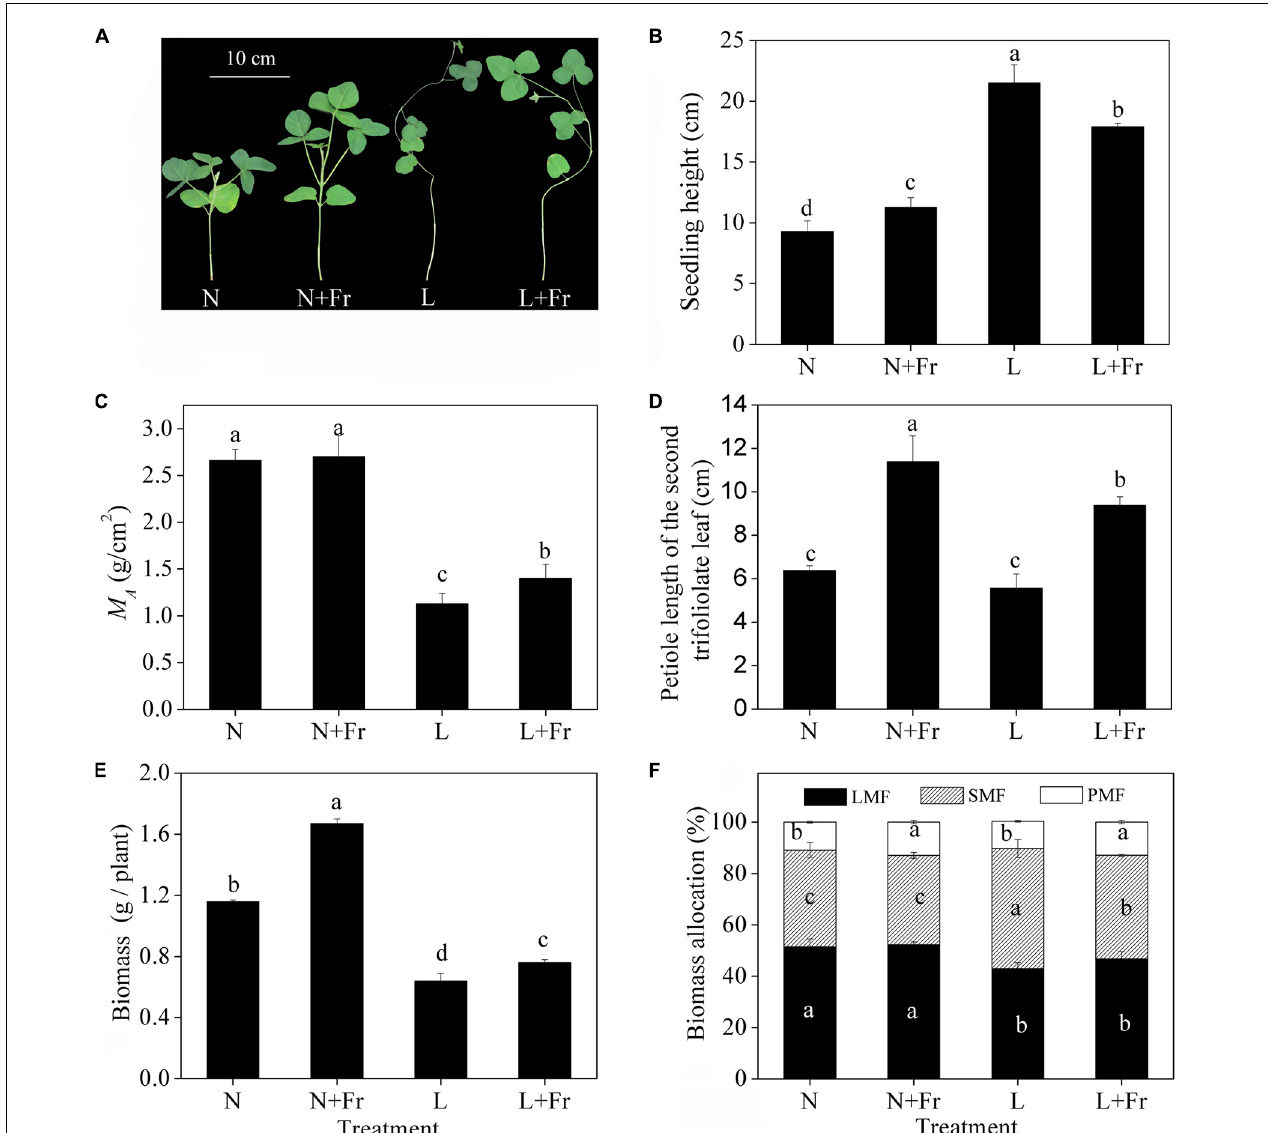
FIGURE 2 | Seedling height (B) , leaf dry mass per unit area ( M A ) (C) , petiole length of the second trifoliolate leaf (D) , biomass (E) , and biomass allocation traits (F) (LMF, SMF, and PMF) of soybean under different light intensity and quality treatments. N, N+Fr, L, and L+Fr denote normal light (normal PAR and normal R/Fr ratio), normal light plus far-red light (normal PAR and low R/Fr ratio), low light (low PAR and normal R/Fr ratio), and low light plus far-red light (low PAR and low R/Fr ratio), respectively. LMF, SMF, and PMF represent leaf mass fraction, stem mass fraction, and petiole mass fraction, respectively. (A) Soybean seedlings grown for 35 days under different treatments. Each value is expressed as the mean ± SE. The means for each treatment that do not have a common letter are significantly different at P = 0.05, according to Duncan’s multiple range